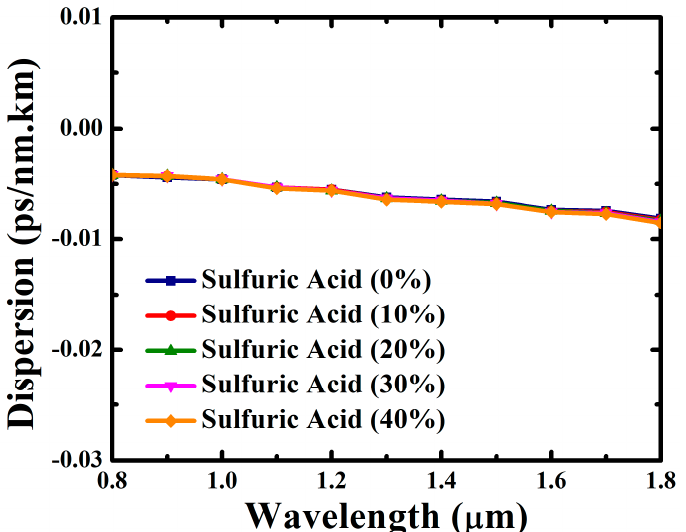
Figure 7. Chromatic dispersion of the proposed PCF sensor with 0%, 10%, 20%, 30%, and 40% concentrations of sulfuric acid for different operating wavelengths.